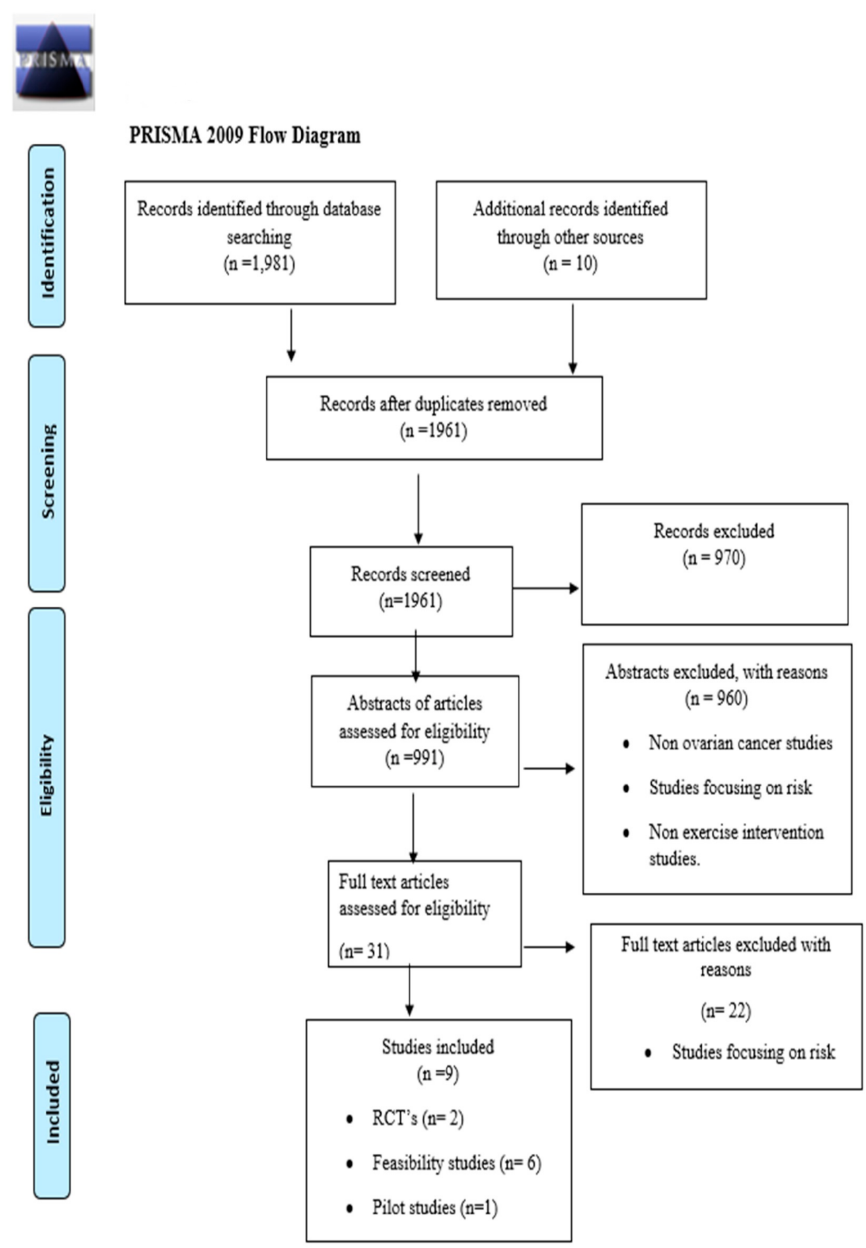
Figure 1. PRISMA 2009 flow